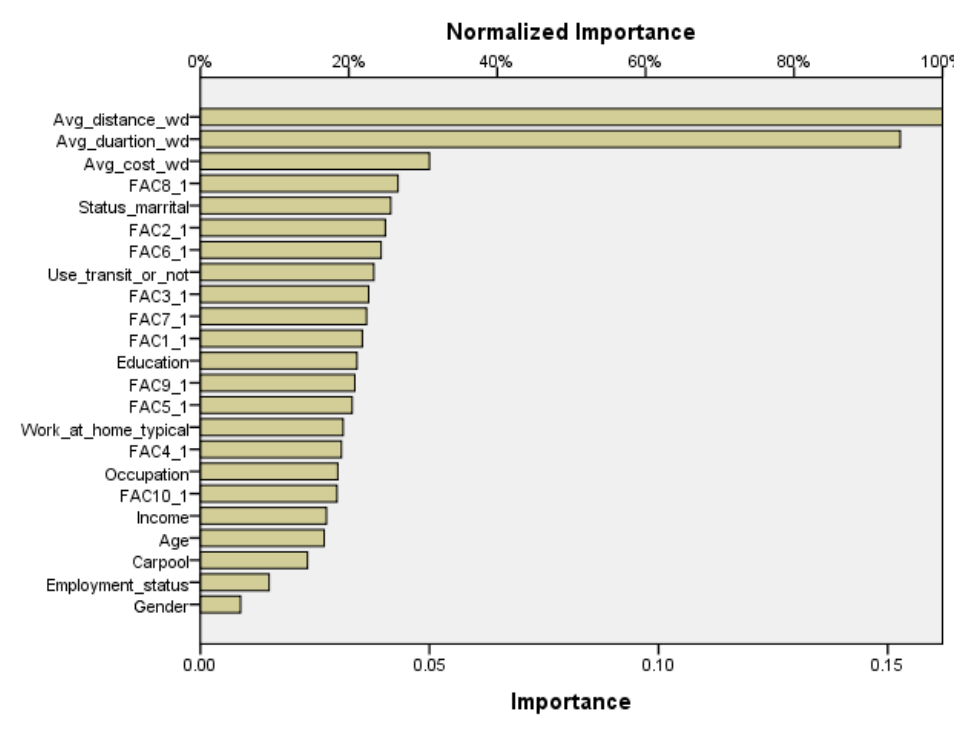
Figure 11. Normalized importance.